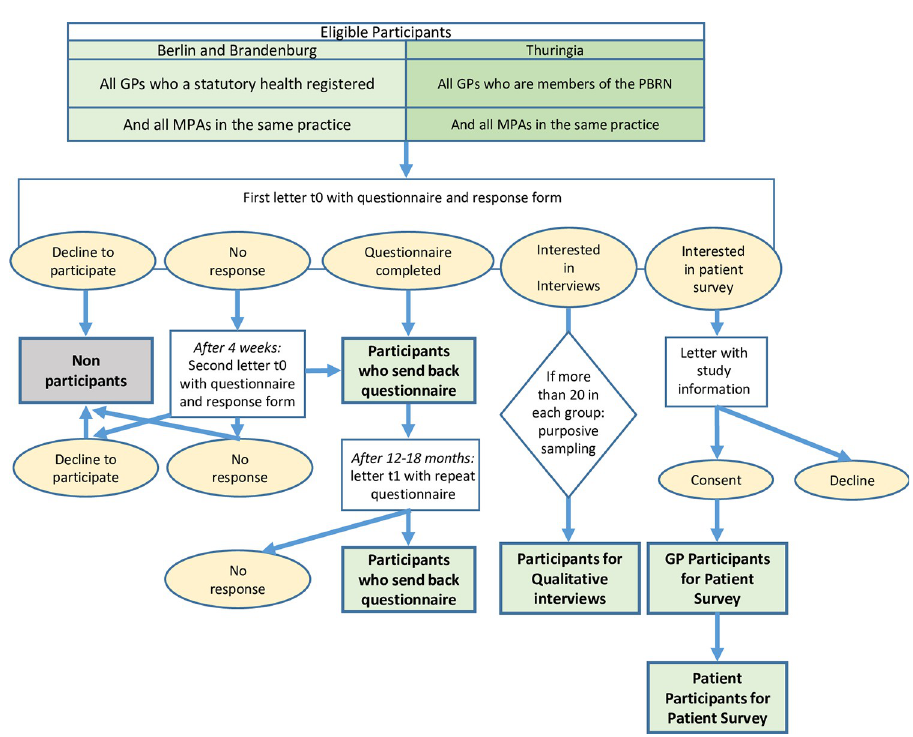
Fig 1. Flow chart of participants.